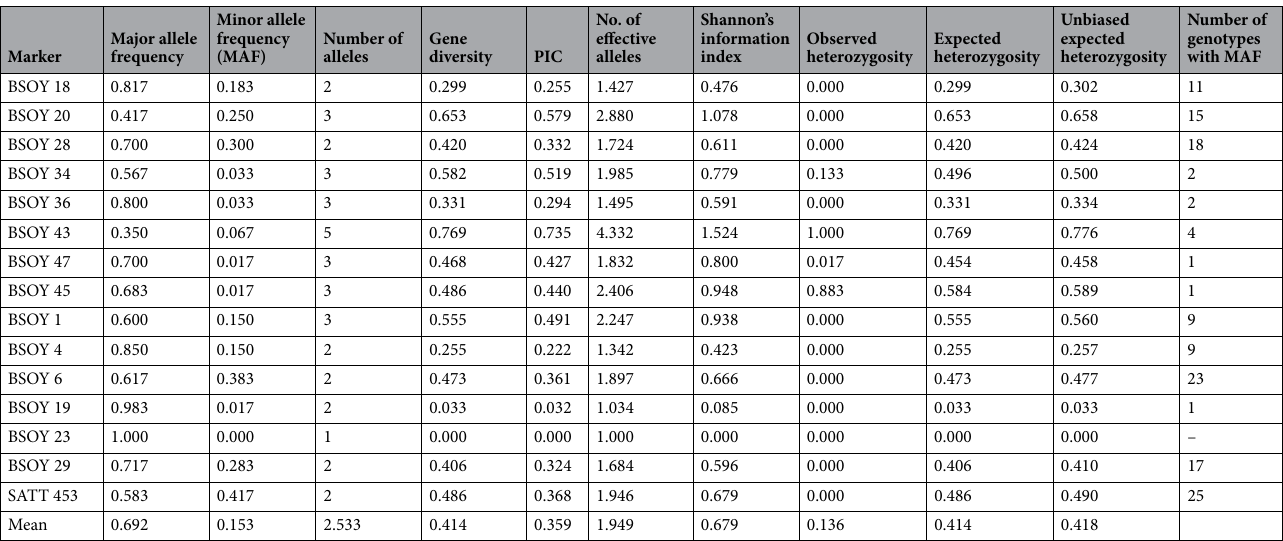
Table 5. Genetic diversity measures of the microsatellite markers in soybean